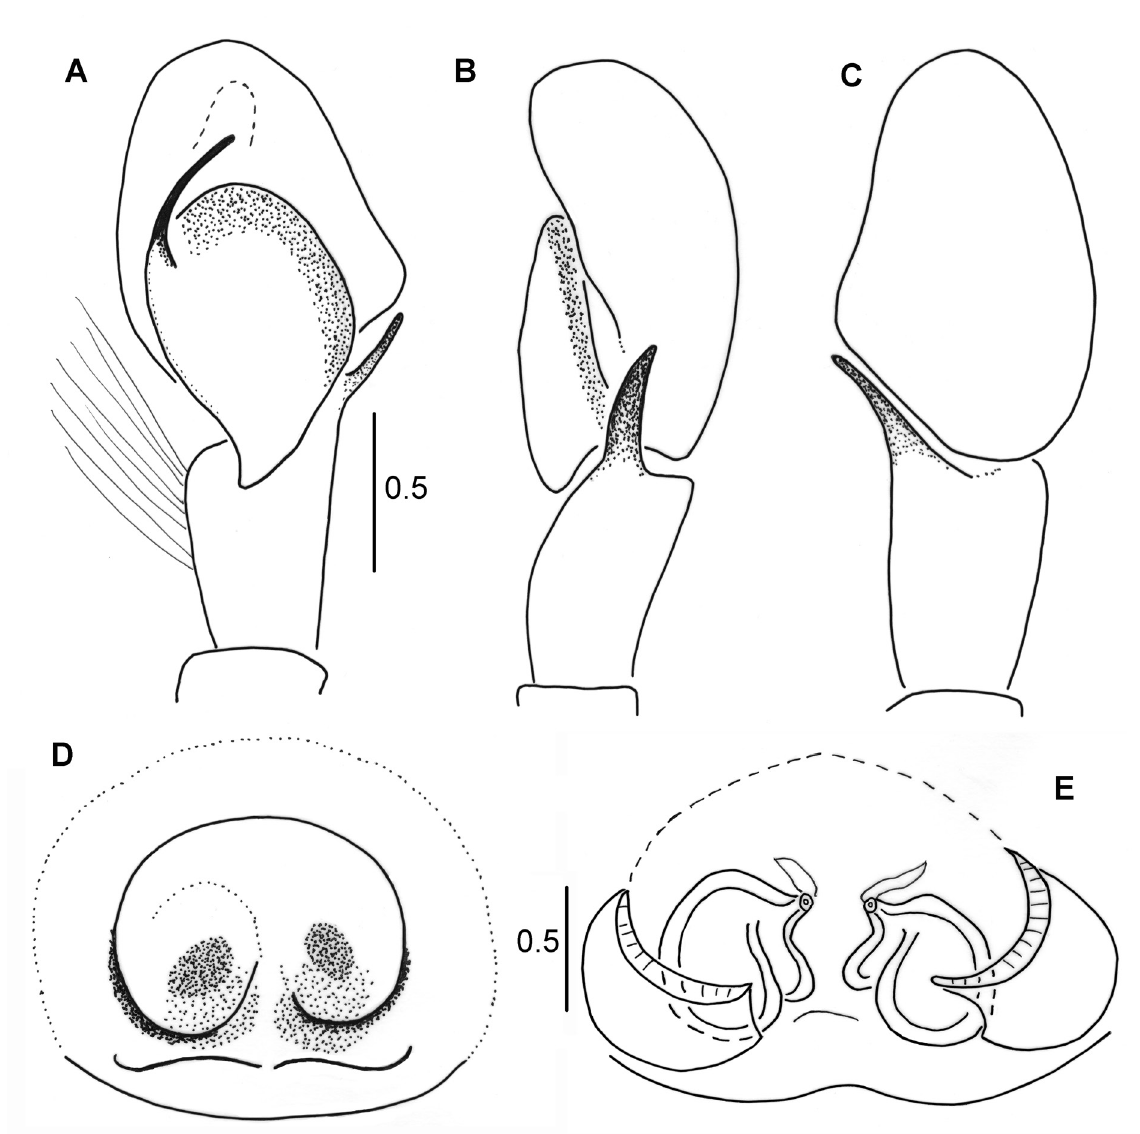
Fig. 25. Hyllus tuberculatus Wanless & Clark, 1975, ♂♀ (MNHN). A . Palpal organ, ventral